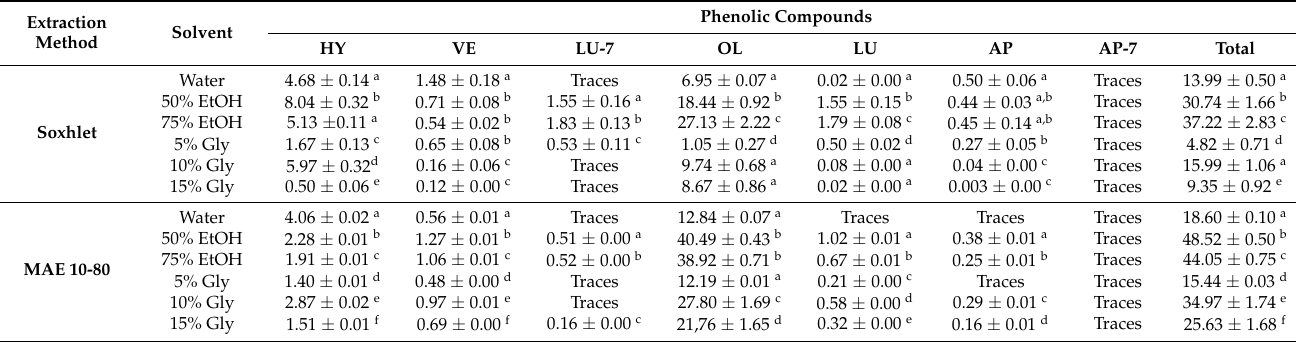
Values are expressed as mean ± standard deviation. A standard deviation value of ‘0.00’ indicates values between 0.0001 and 0.0039. Within each extraction method, different superscript letters in the same column indicate values significantly different ( p < 0.05) according to Tukey’s Multiple Range Test. Abbreviations: HY, hydroxytyrosol; VE, verbascoside; LU-7, luteolin-7-O-glucoside; OL, oleuropein; LU, luteolin; AP, apigenin; AP-7, apigenin-7-O-glucoside; Total, sum of individuals. Traces: under LOD (limit of